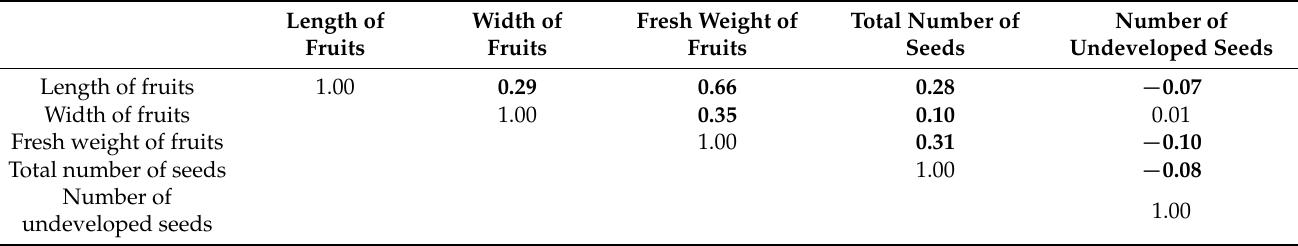
Table 11. The Pearson coefficient ( p < 0.05) between the length, the width, and the fresh weight of fruits, as well as the total number of seeds and number of undeveloped seeds in Echinocystis lobata . The statistically significant values are in bold.